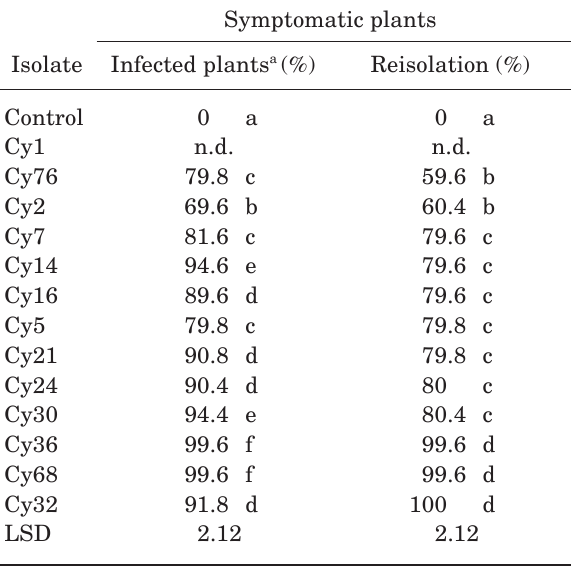
Table 4. Results of pathogenicity tests of Cylindrocar- pon destructans isolates on rooted grapevine cuttings of cv.